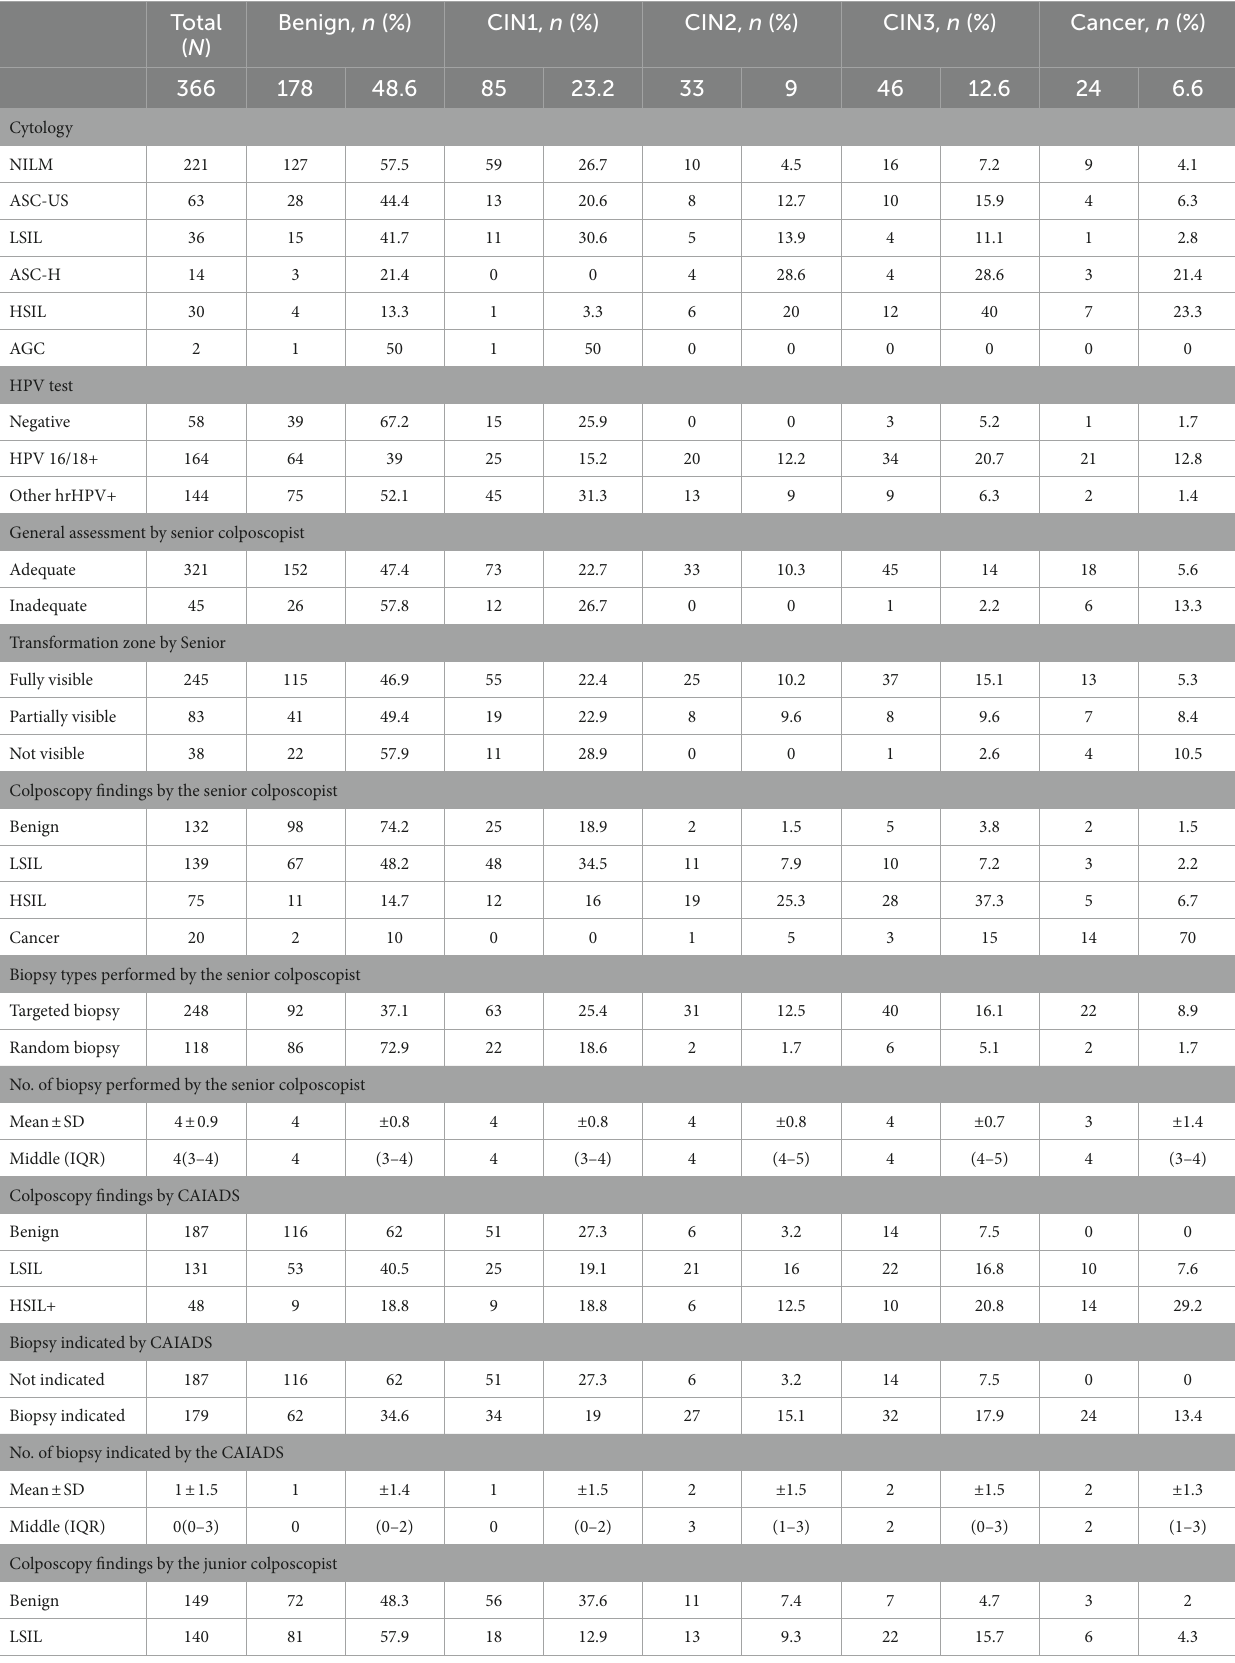
TABLE 2 Human papillomavirus (HPV), cytological, and colposcopic findings by histological diagnosis. Total Benign, n (%) CIN1, n ( N )